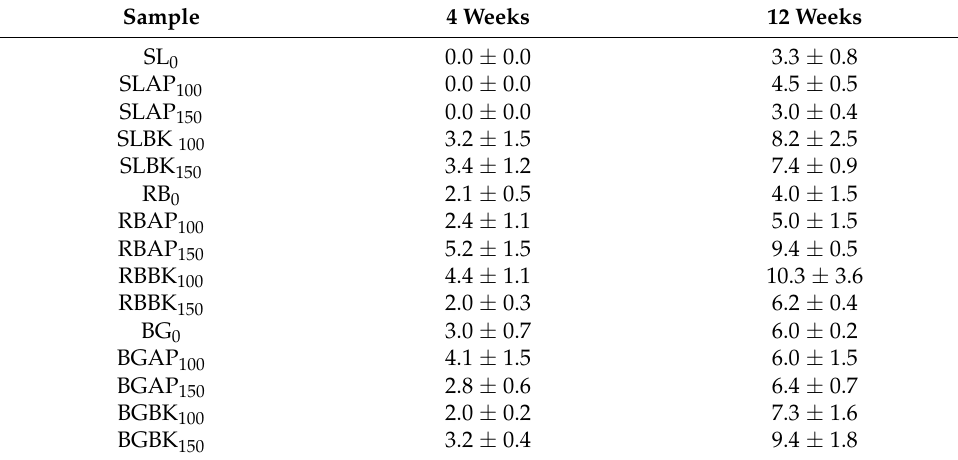
Table 2. Average live and dead insects ( Tribolium casteneum ) for different storage strategies for selected weeks.